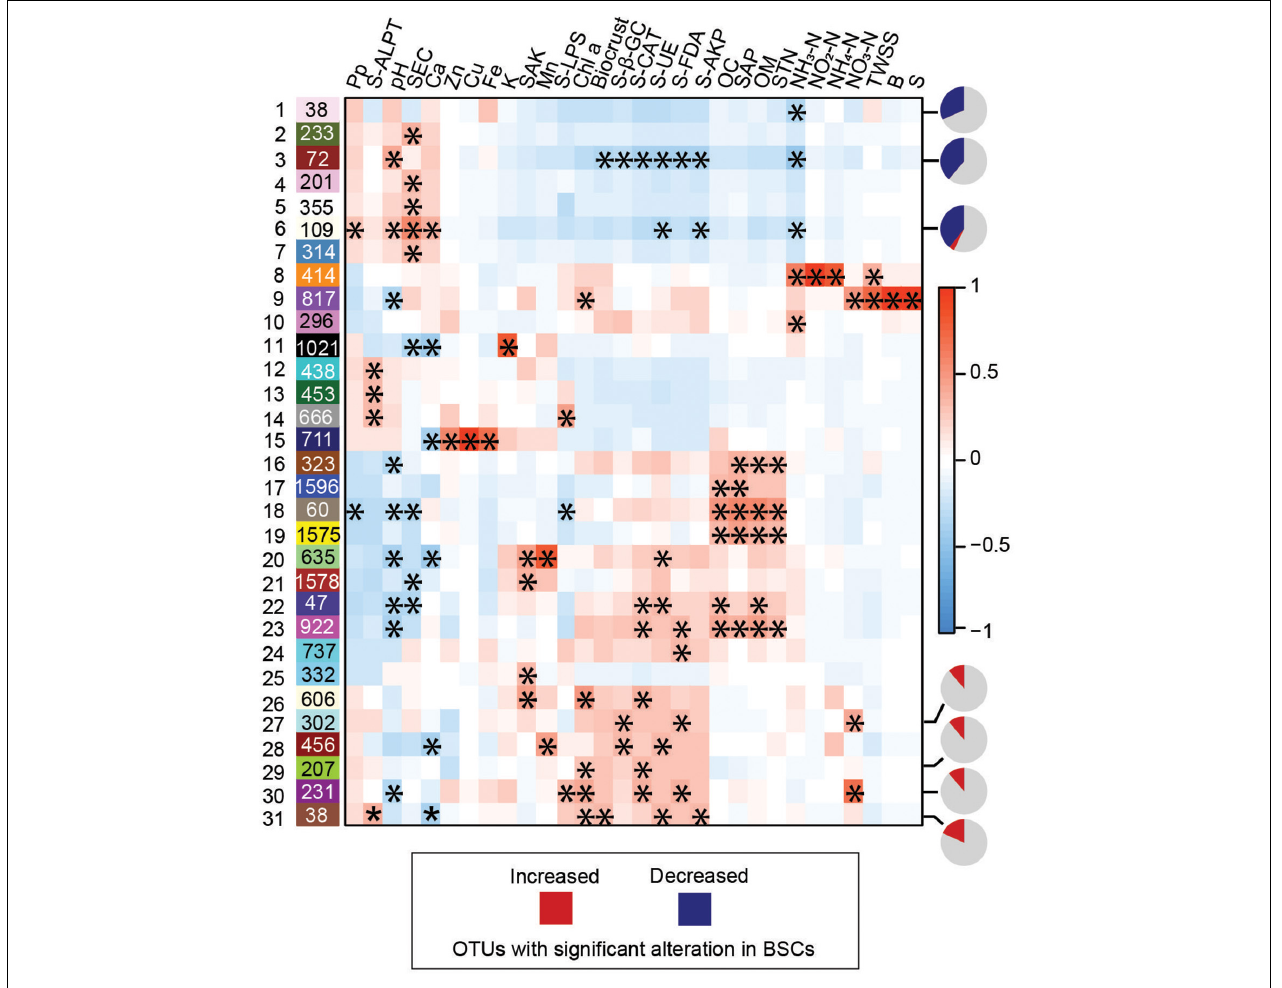
FIGURE 4 | Weighted gene co-expression network analysis (WGCNA). The correlation among 53 modules ( Y -axis) and 31 soil properties ( X -axis) are illustrated in the heatmap. Positive correlation value is represented by red and negative by blue. The “*” in the cells are presented as microbial module significantly correlating with soil properties ( P < 0.05). Pie charts on the right side of the indicated modules represent the percentage of significantly increased (red) and decreased (blue) OTUs in biocrust. Pp, Precipitation; B, Soil Available Boron; OM, Organic Matter; OC, Organic Carbon; SAP, Soil Available Phosphorus; SEC, Soil Exchangeable Calcium; SAK, Soil Available Kalium; K, Kalium; Ca, Calcium; Zn, Soil Available Zinc; Cu, Soil Available Copper; Fe, Soil Available Iron; Mn, Soil Available Manganese; TWSS, Total Water Soluble Salt; STP, Soil Total Phosphorus; S, Soil Available Sulfur; STN, Soil Total Nitrogen; NO 2 -N, Soil Nitrite Nitrogen; NO 3 -N, Soil Nitrate Nitrogen; NH 4 -N, Soil Ammonium Nitrogen; NH 3 -N, Soil Ammonia Nitrogen; Chl a , chlorophyll a ; S- β -GC, soil β -glucosidase activity; S-LPS, soil lipase activity; S-FDA, soil FDA hydrolase activity; S-ALPT, soil alkaline protease activity; S-UE, soil urease activity; S-AKP, soil alkaline phosphatase activity; S-CAT, soil catalase